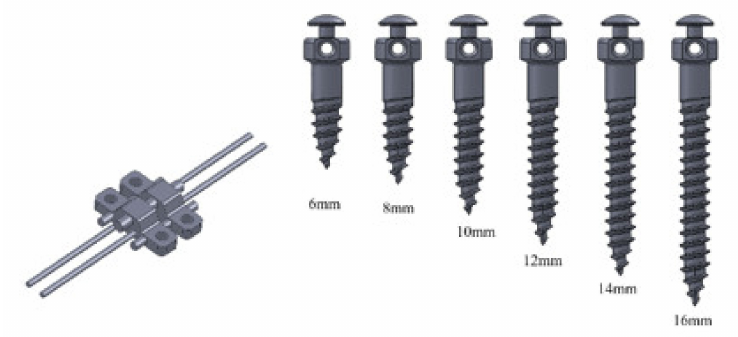
Figure 2. SME expansion screw and miniscrews of the FEA model.